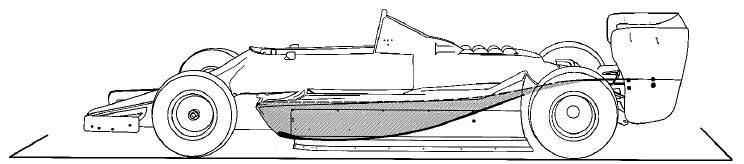
Figure 1. Basic catamaran body